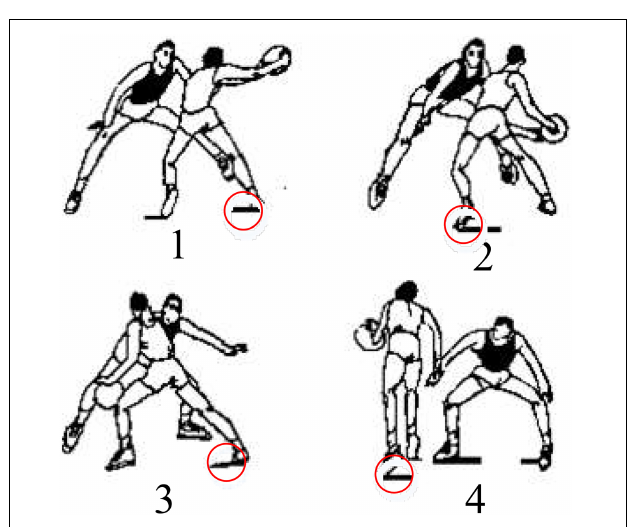
FIGURE 2 | Analysis on the movement of right false shaking to the left. FIGURE 3 | Influence of different batch sample numbers and iteration times on the recognition effect.